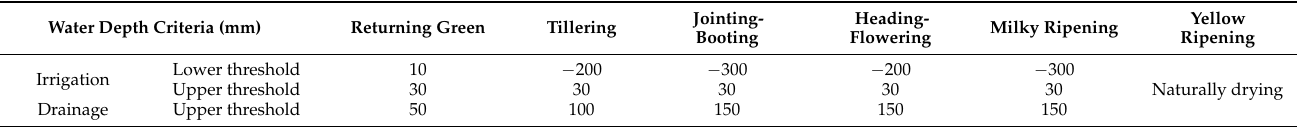
Table 2. Water management strategy under the controlled irrigation and drainage (CID) regime. Water Depth Criteria (mm) Returning Green Tillering Jointing- Booting Heading- Flowering Milky Ripening Yellow